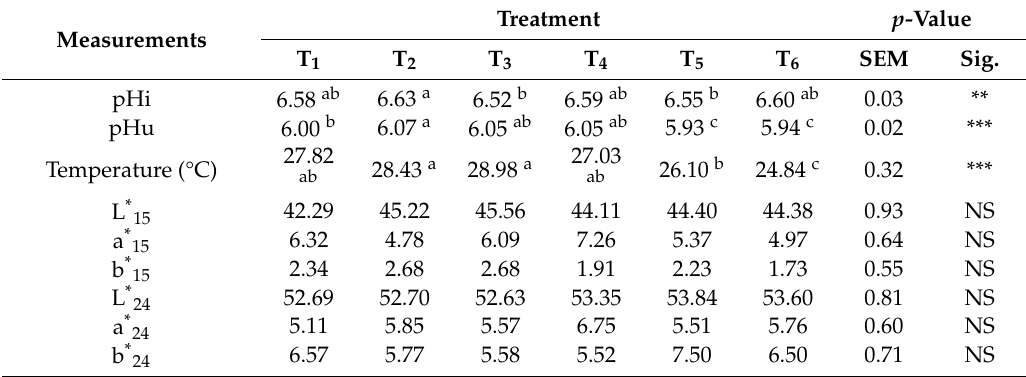
Table 4. E ff ects of some feed additives on the meat quality of broilers challenged with C. perfringens during a feeding trial